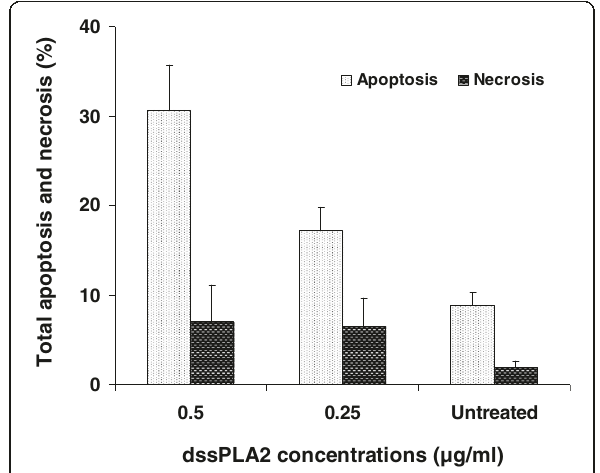
Fig. 3 Total apoptosis and necrosis of SK-MEL-28 cells were induced by incubation with dssPLA 2 for 24 h. Results are expressed as mean ± SE ( n = 4)